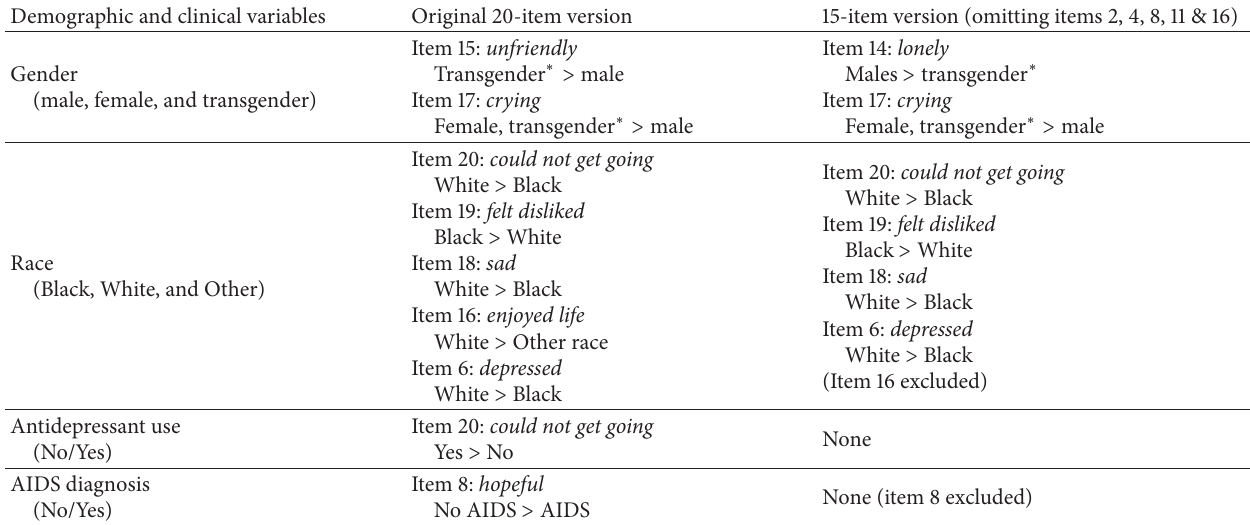
Table 5: Differential item functioning in the original 20-item CES-D and a 15-item version. Demographic and clinical